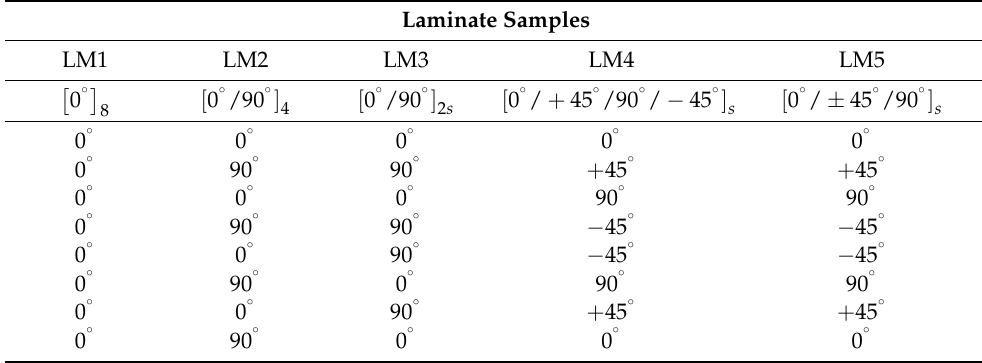
Table 2. Schematic representation of the laminate ply stacking sequences. Laminate